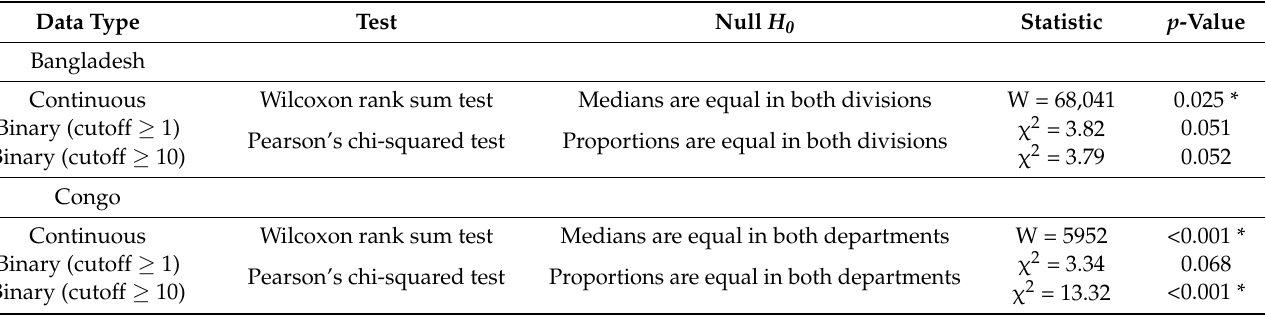
Table 3. Comparison between FIB concentrations in two administrative units (divisions in Bangladesh and departments in Congo) using binary and continuous